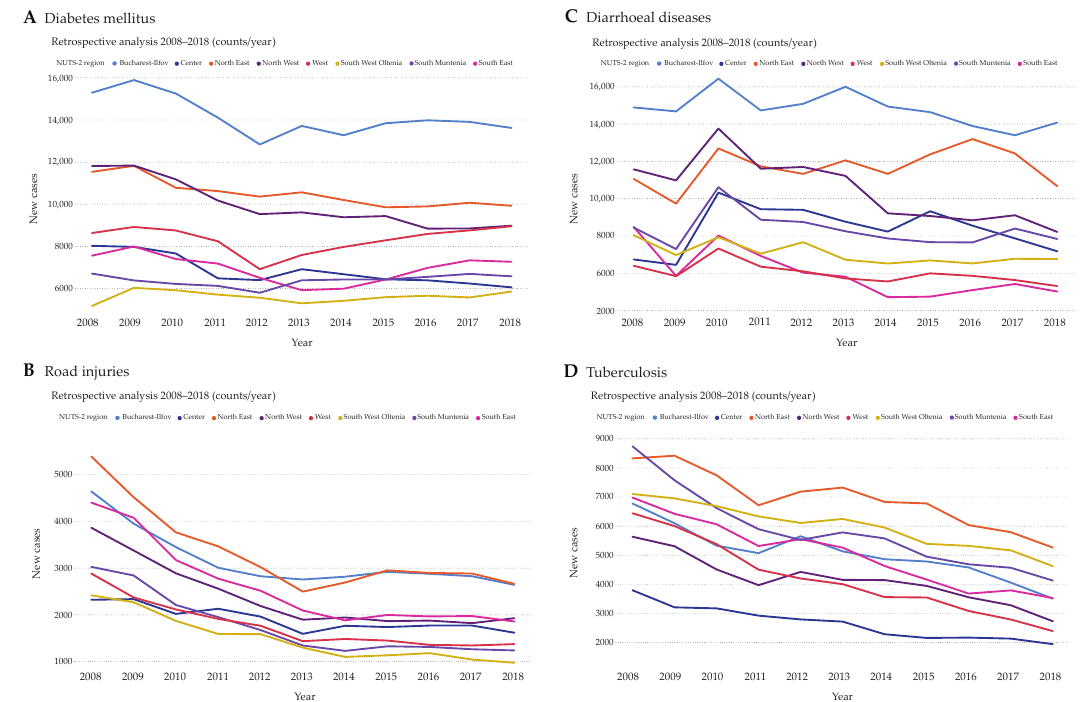
Figure 2. Total case counts of patients hospitalized due to diabetes mellitus ( A ), road injuries ( B ), diarrheal diseases ( C ), and tuberculosis ( D ). Only diseases encoded as main diagnoses that facilitated hospitalization were counted for every NUTS 2 region of Romania per year over the period